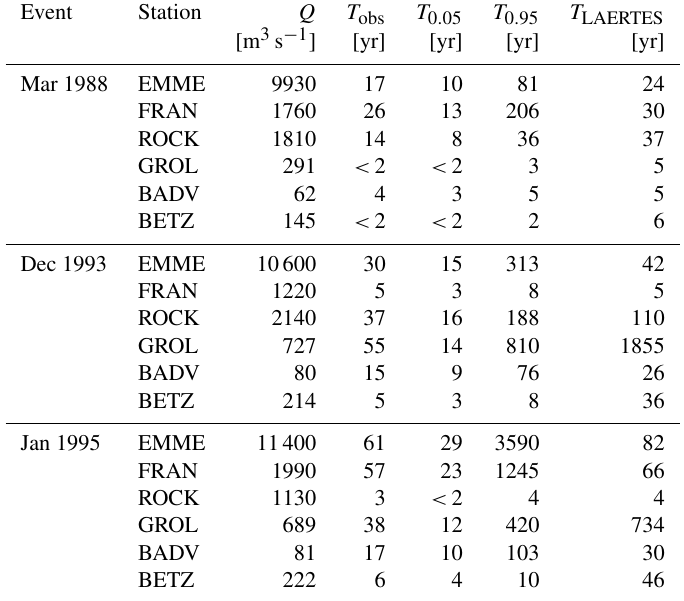
Table 3. Return interval T obs of the peak discharge Q for selected historical flood events and stations (sorted in descending order regarding catchment size; see Table 2) estimated from the Q Obs-Weibull distribution and 95% CI ( T 0 . 05 and T 0 . 95 ) and bias-corrected LAERTES-EU data T LAERTES